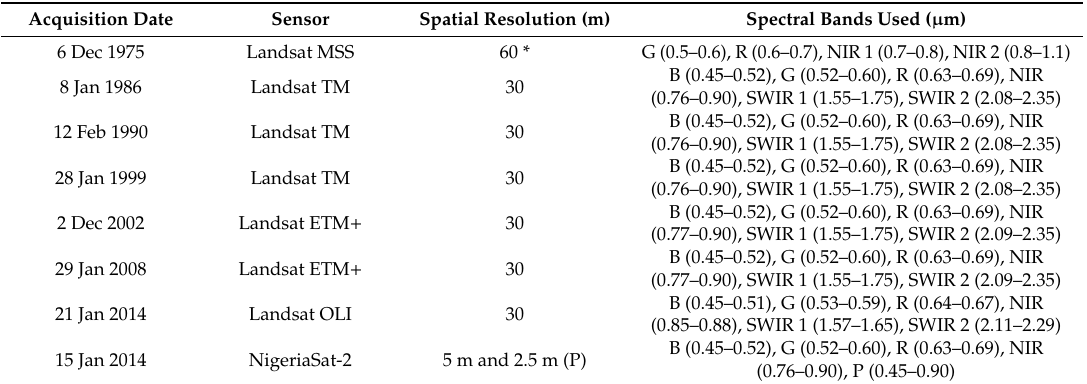
Table 1. Multi-temporal Landsat time-series and NigeriaSat-2 imagery used to analyze urbanization in Abuja (MSS = multispectral scanner, TM = thematic mapper, ETM + = enhanced thematic mapper plus and OLI = operational land imager; B = blue, G = green, R = red, NIR = near infrared, SWIR = shortwave infrared and P =